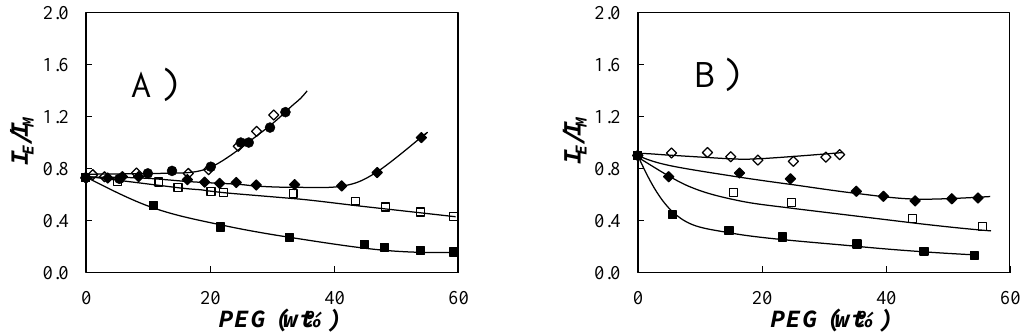
Figure 4. Plots of I E / I M as a function of poly(ethylene glycol) (PEG) concentration for ( A )